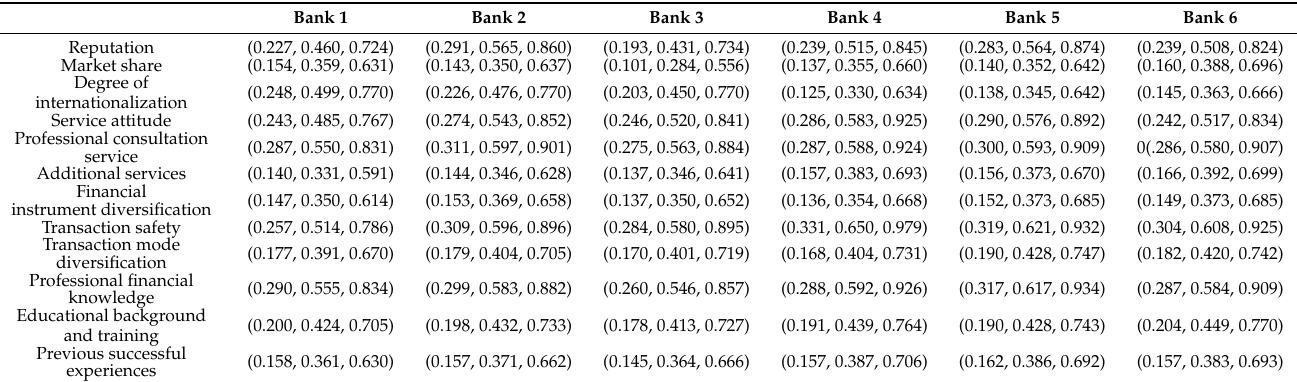
Stage 4: Construct the weighted normalized fuzzy evaluation framework. The weighted normalized fuzzy evaluation framework was then calculated as in Table 6. Table 6. Weighted normalized fuzzy decision-making